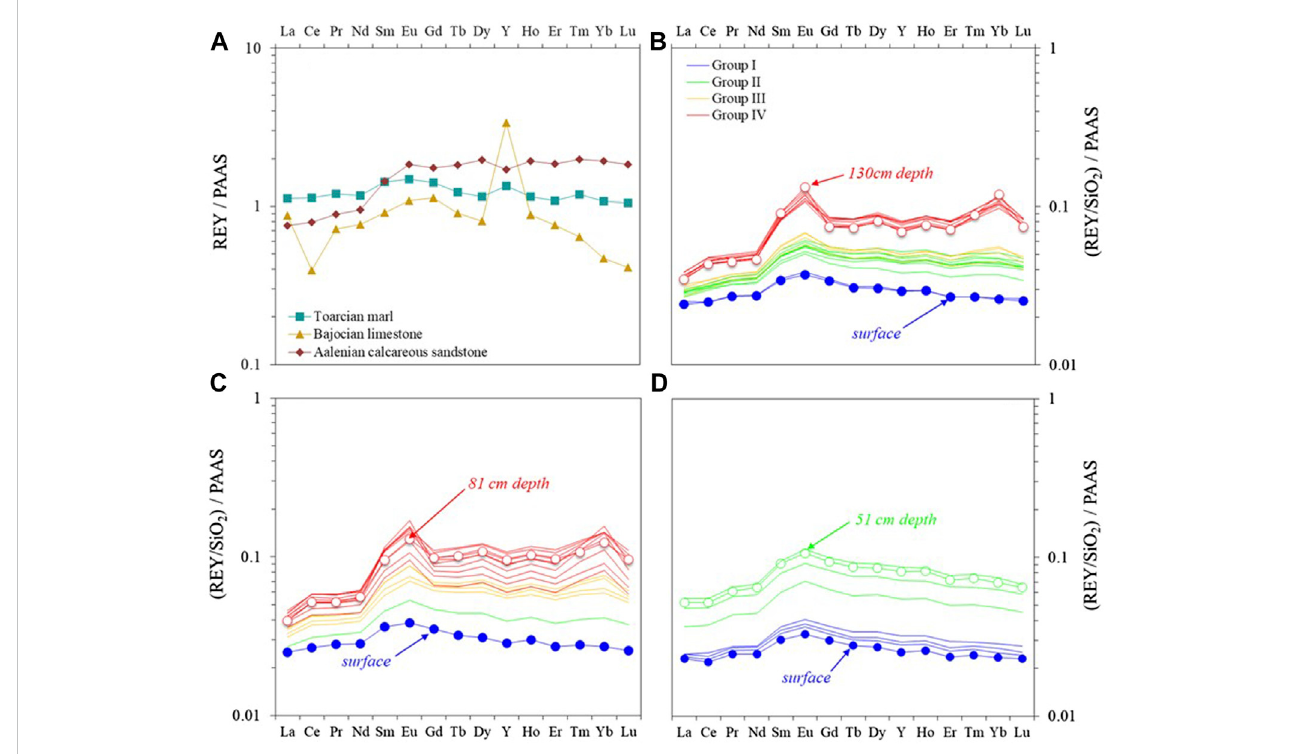
FIGURE 4 PAAS-normalized REY patterns of bedrocks covering the Orne River basin (A) and of the three selected riverbank cores normalized by the SiO 2 content [ (B) : BETHUP, (C) JOEP, (D) JOSAN]. The groups are de fi ned according to Kanbar et al. (2017).